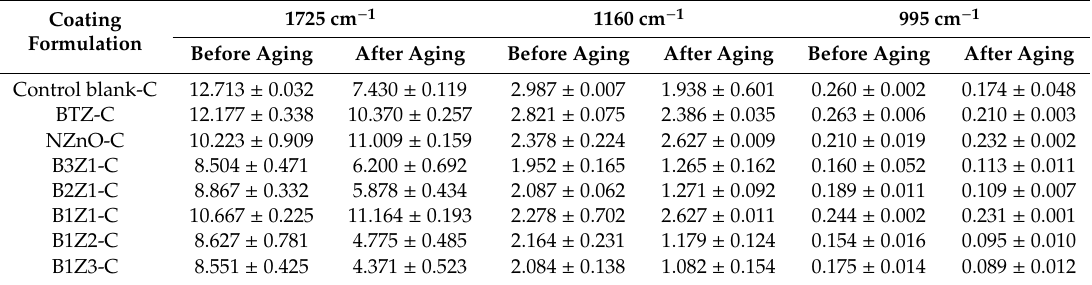
Figure 9. Changes in FTIR-ATR spectra of di ff erent film formulations in the region of 1800–800 cm − 1 . Table 5. Changes in the intensity of the bands at 1725, 1160 and 995 cm − 1 after 500 h of aging of the